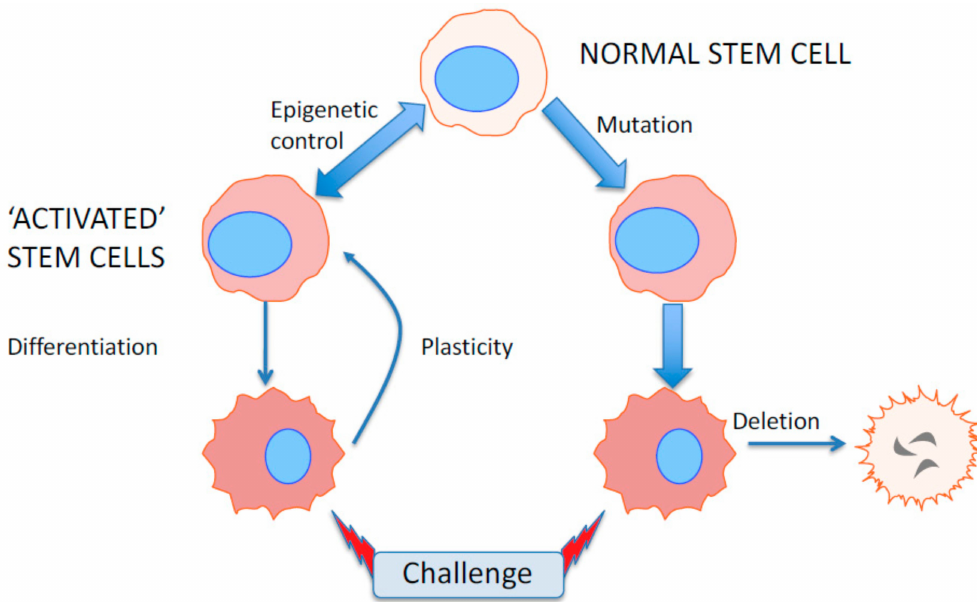
Figure 7. Epigenetic control of gene silencing and clonal deletion in prostate cancer development. Epigenetic gene activation / repression allows the activated stem cells in cancer or pre-cancer to revert to a resistant phenotype when challenged with extrinsic or intrinsic mutant cell deletion whereas mutational activation cannot be reversed, allowing the cells to be